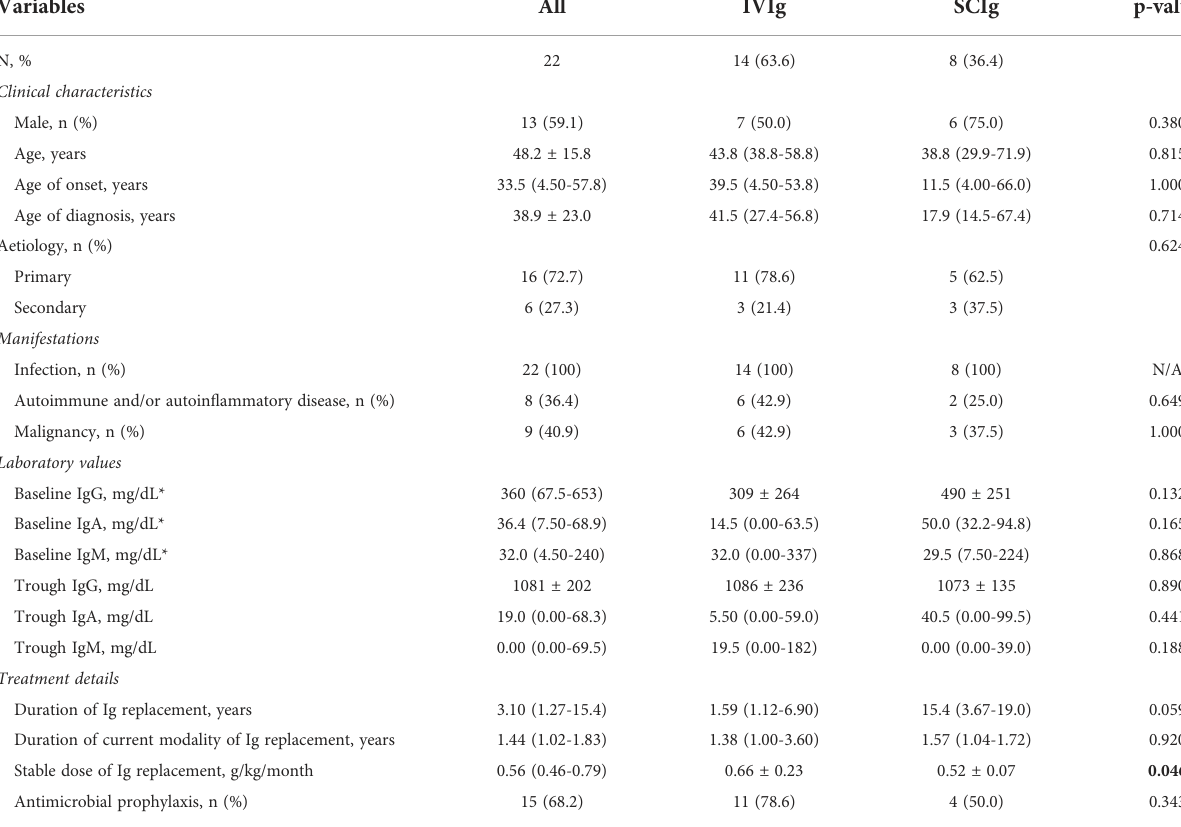
TABLE 1 Demographics and clinical features of patients on regular IVIg and SCIg